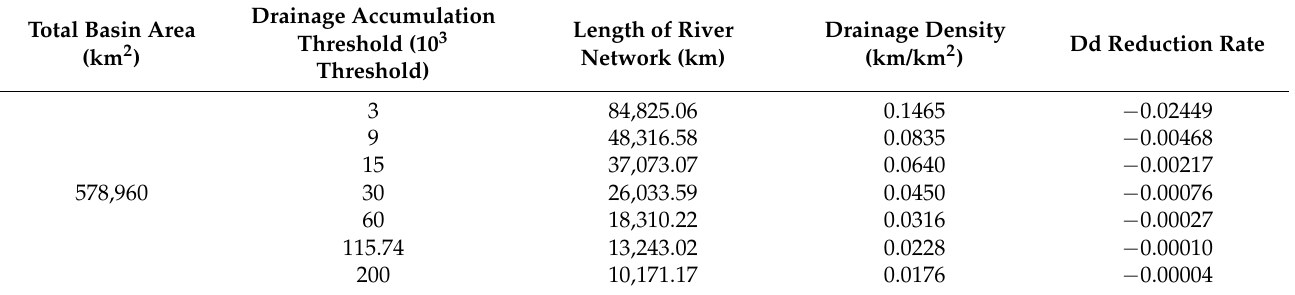
Table 4. Relationship between drainage density and drainage accumulation thresholds in the PRB. Total Basin Area (km 2